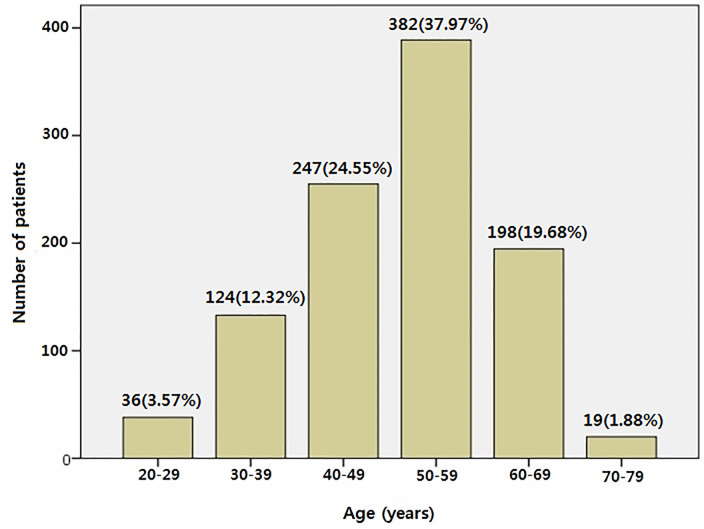
Age distribution of deceased donors.